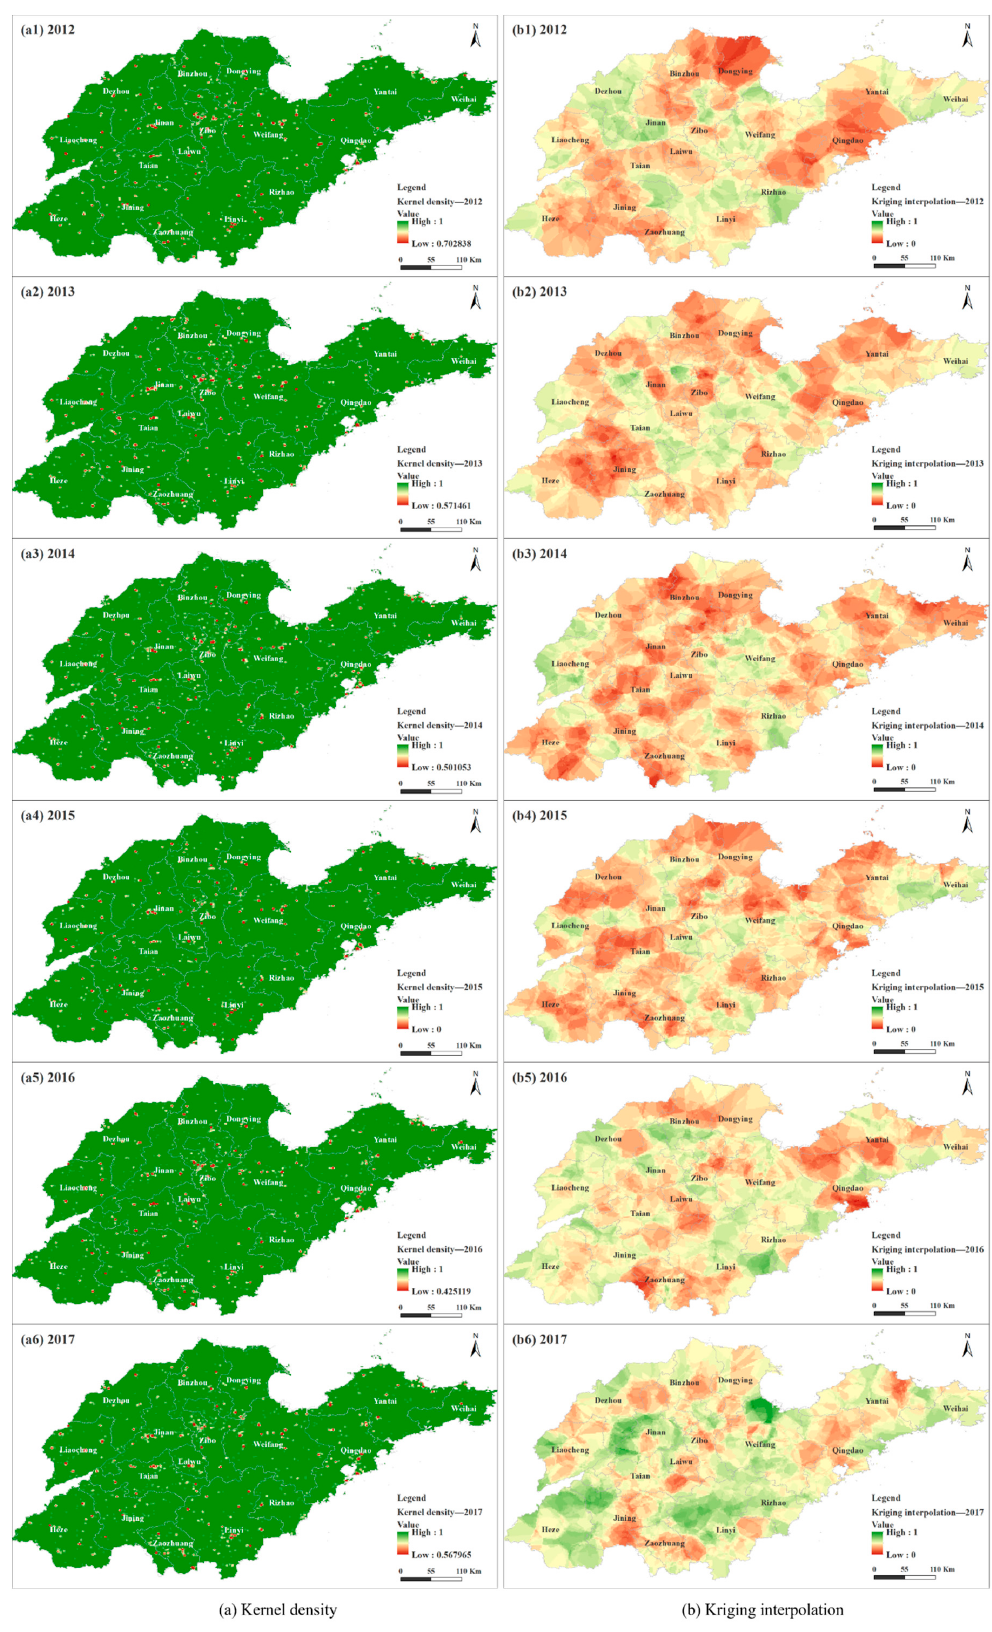
Figure 3. Spatial distribution of air pollution complaint density ( a ) and complaint emotion intensity ( b ) based on Kernel density and Kriging interpolation in Shandong Province from 2012 to